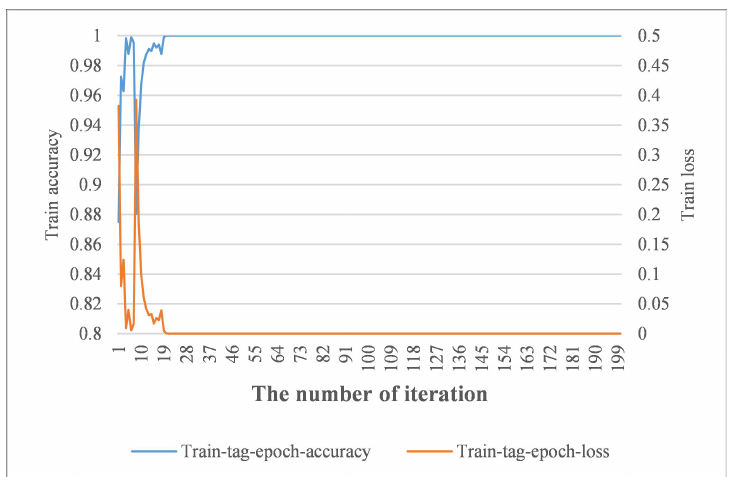
Figure 11. Structure diagram of